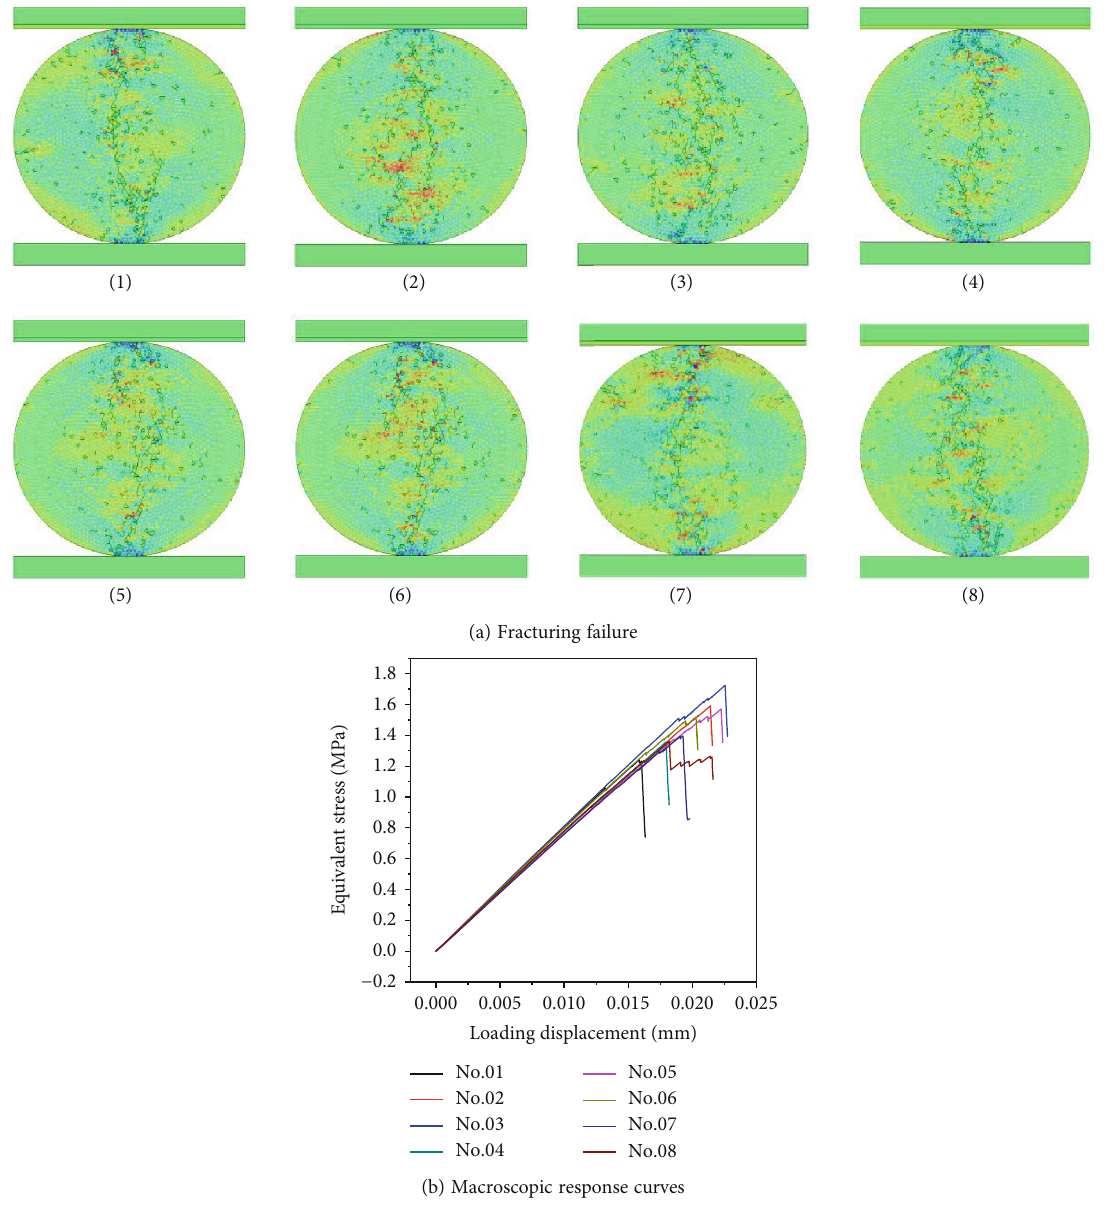
Figure 4: Simulation results of the disc when m = 1 : 5